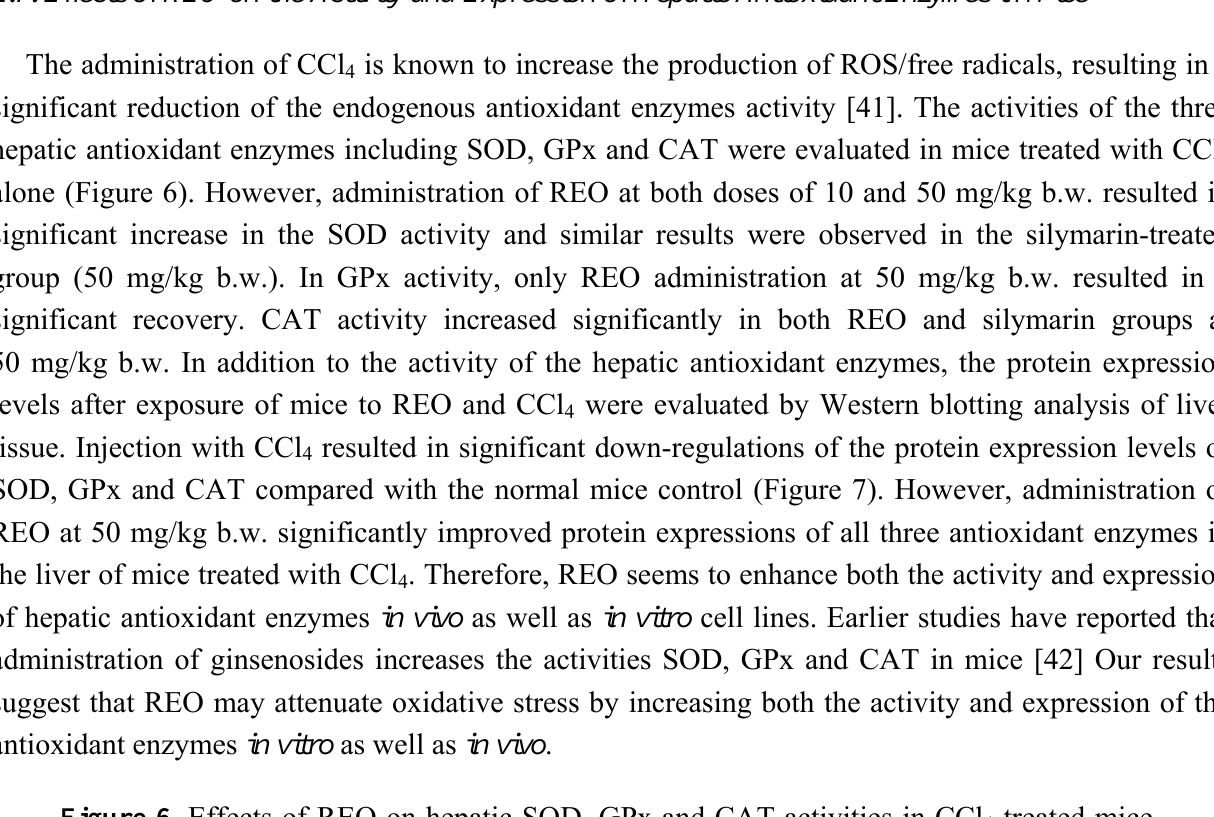
Figure 6. Effects of REO on hepatic SOD, GPx and CAT activities in CCl